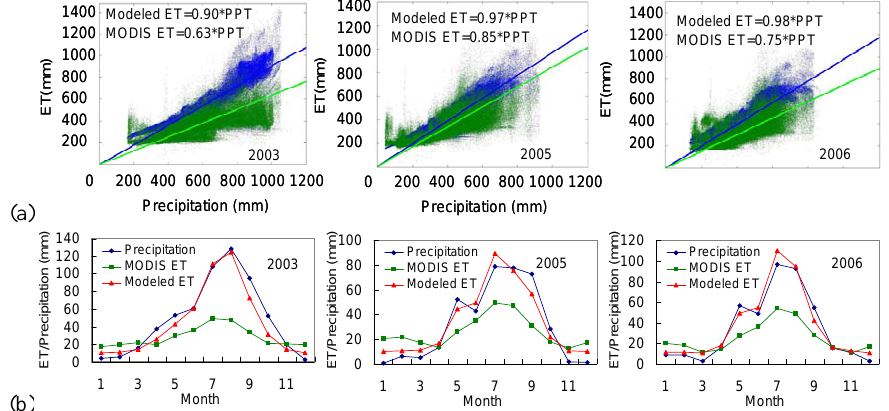
Fig. 4. (a) Pixel to pixel comparison between modelled ET and MODIS ET products in a dry year (2005), wet year (2003) and for average conditions (2006); (b) the monthly data comparison between modelled ET and MODIS ET products in a dry year (2005), wet year (2003) and for average conditions (2006).